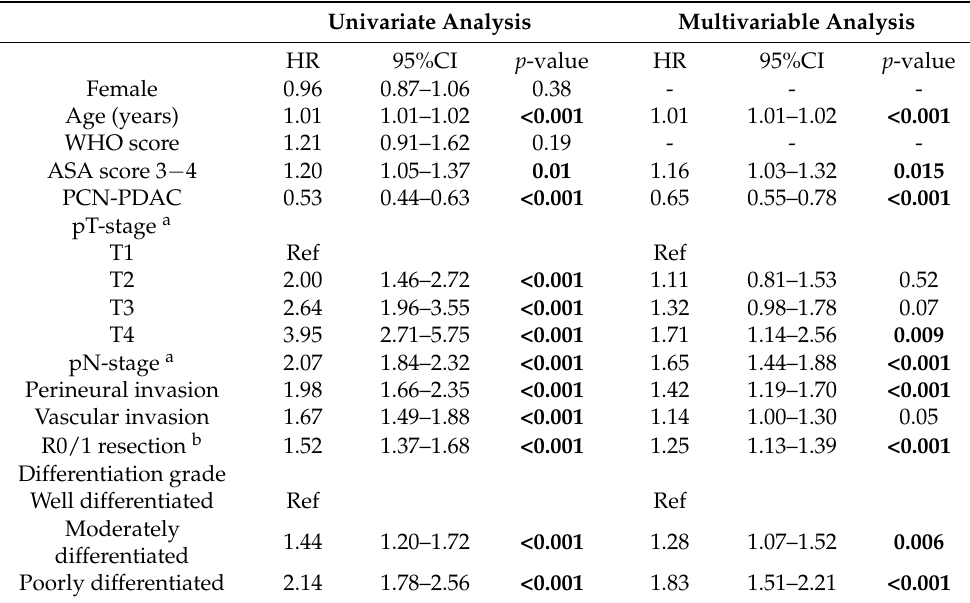
Figure 2. Kaplan–Meier estimates of overall survival after resection of PCN-PDAC versus PDAC not associated with PCN. Abbreviations: CI = confidence interval. HR = hazard ratio. PDAC = pancreatic ductal adenocarcinoma. PCN = pancreatic cystic neoplasms. Table 2. Cox regression analyses evaluating factors associated with overall